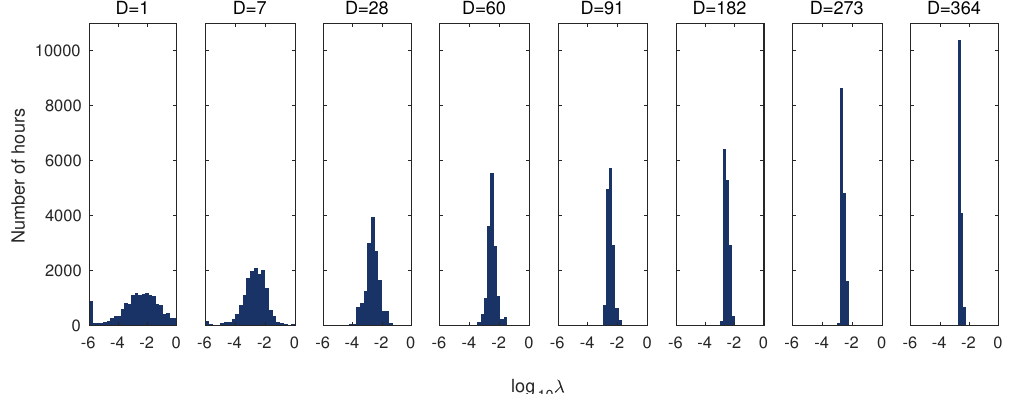
Figure 7. Histograms displaying the number of hours for which a given value of λ was selected in the whole Nord Pool test period (24 × 631 = 15,144 h) across different D s and for the N-PIT -transformed 2xN Lasso D model. Recall, that we considered 25 exponentially decreasing λ s ranging from 10 0 to 10 − 6 ; 2 they are plotted on a logarithmic scale on the X -axis. The histograms for PJM data look very similar (not